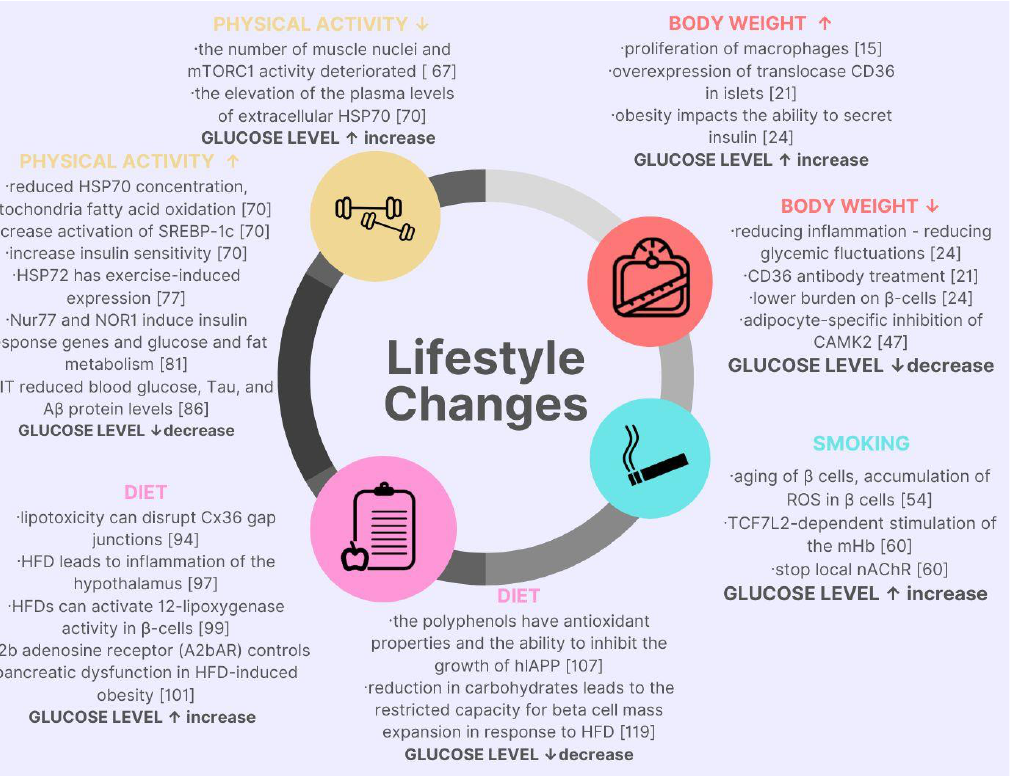
Figure 1. Graphic summary of lifestyle changes in the context of molecular cell changes and their impact on glycemic levels. Table 2. Factors affecting glucose fluctuations in the context of molecular discoveries.